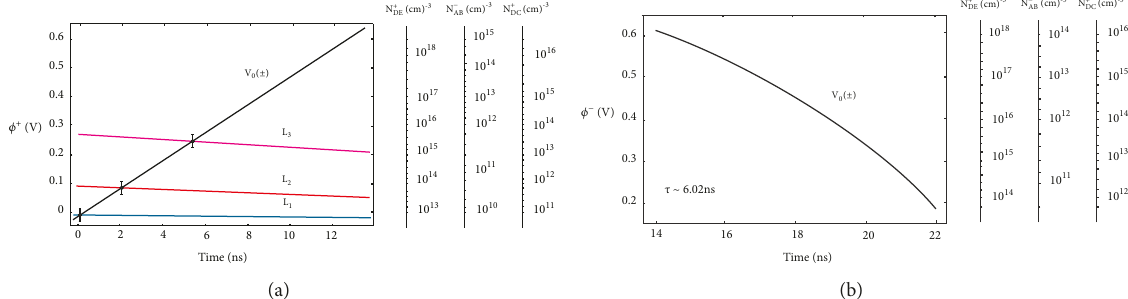
Figure 5: Dynamical behavior of the transistor action at 𝐼 𝐶 = 30𝑚𝐴 and 𝑉 𝐵𝐸 = 0.65𝑉 .